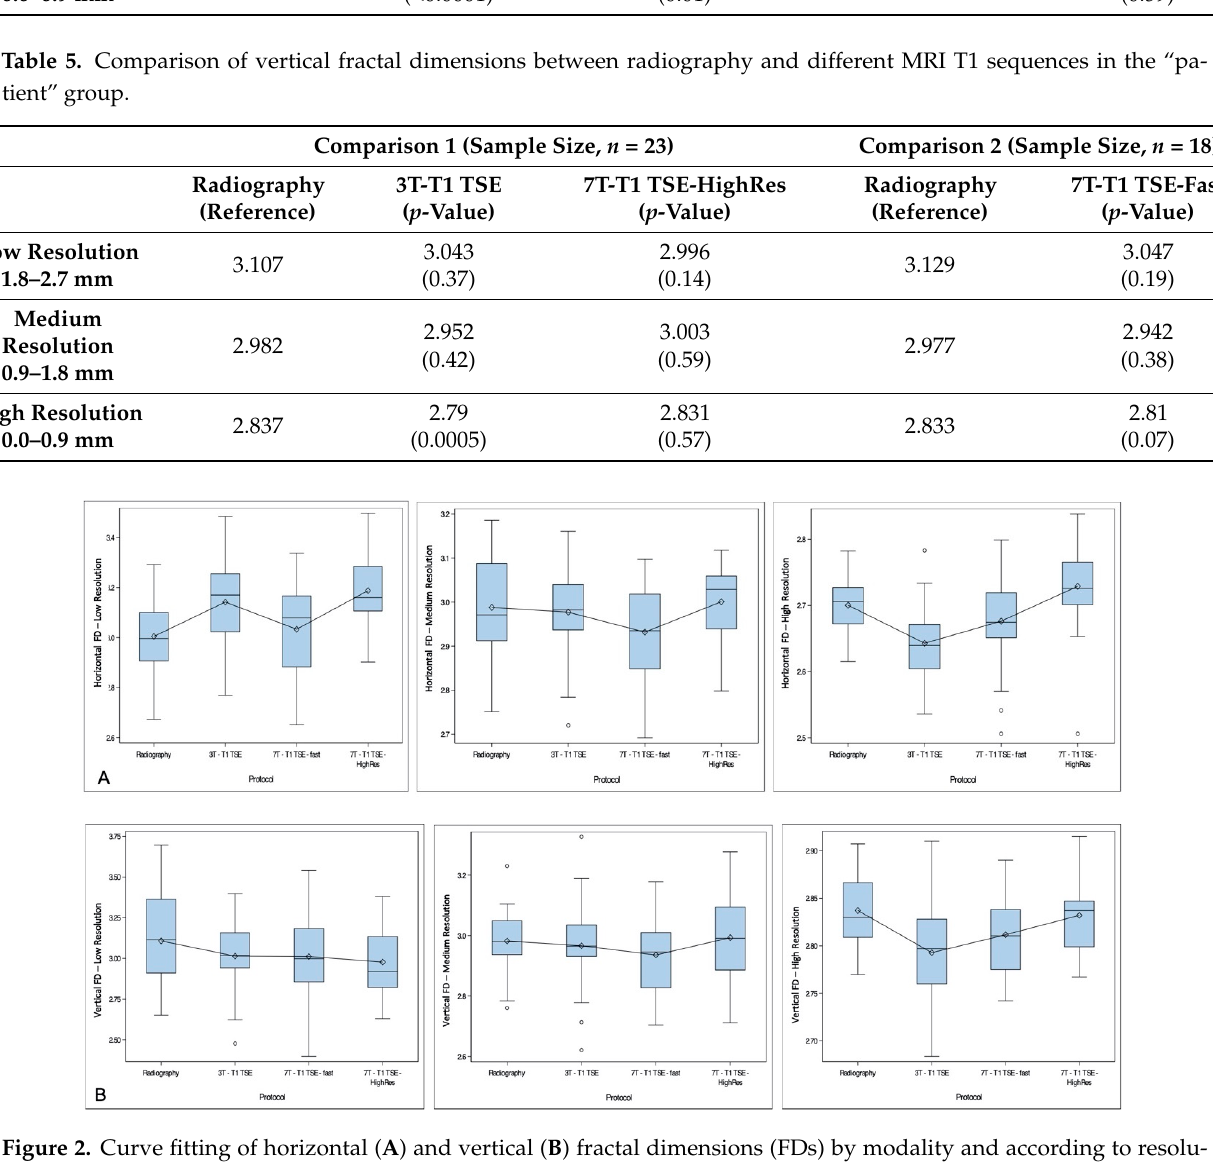
Figure 2. Curve fitting of horizontal ( A ) and vertical ( B ) fractal dimensions (FDs) by modality and according to resolution mode. Each modality is presented in the X-axis, with FD in the Y-axis. High-, medium- and low-resolution curves are presented separately. No consistent distribution of FDs is found between the different resolution modes. However, for the high-resolution mode, horizontal and vertical FDs extracted from 3T T1w STE images appear to be lower than FDs extracted from other imaging modalities. In medium resolution, FDs extracted from 7T T1w TSE-fast appear to be slightly lower than those extracted from other imaging modalities.